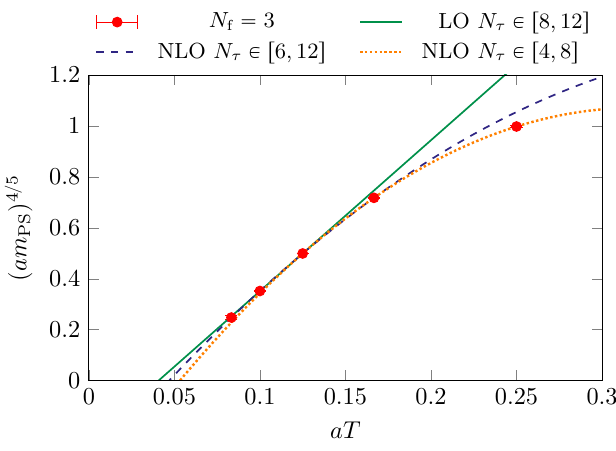
Figure 12. Tricritical scaling of the critical pseudoscalar mass for N f = 3 clover-improved Wilson fermions. The data are taken from table IV in ref.